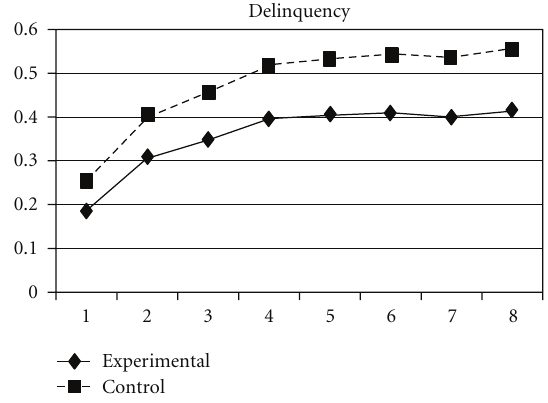
Figure 1: Growth trajectories of the experimental group (all par- ticipants) and control group using delinquency scale score as the outcome indicator.